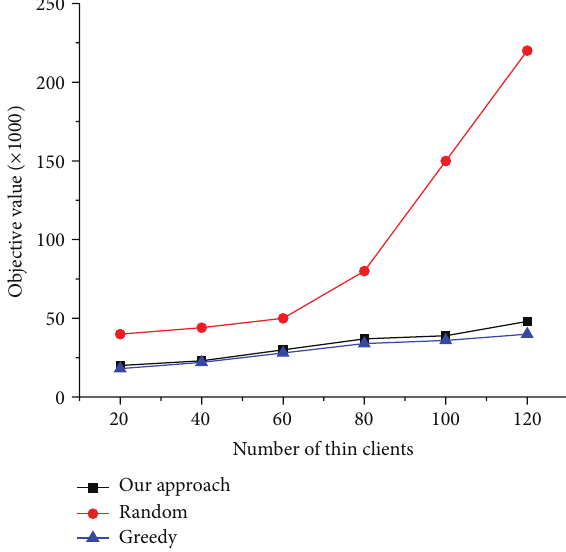
Figure 4: Comparison without user mobility.